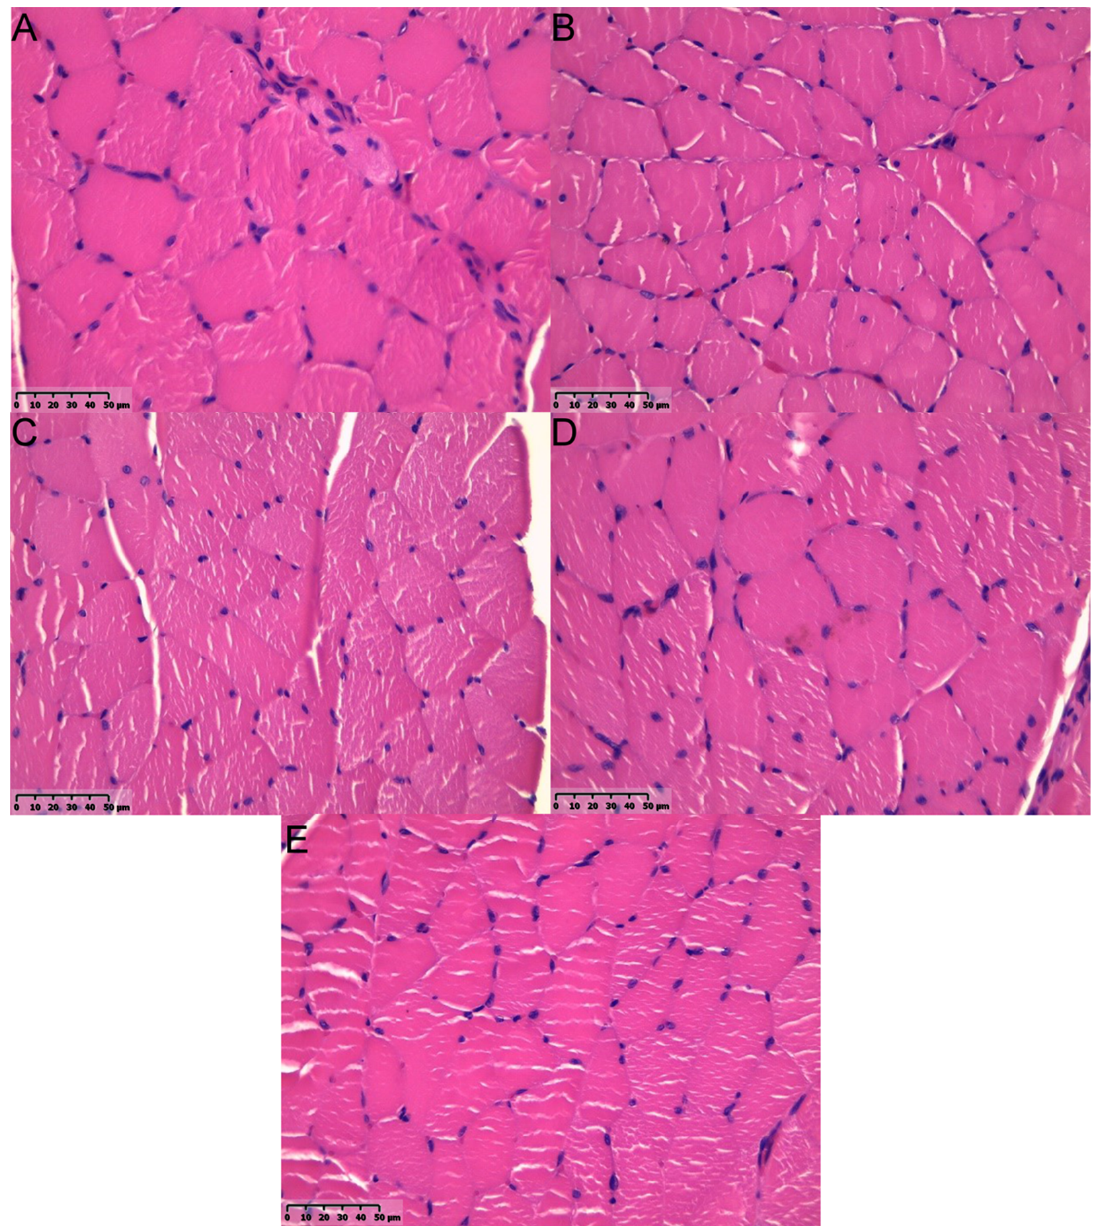
Figure 6. HE images of gastrocnemius muscle sections from the operated limb ( A – D ) and from random unoperated limb ( E ). ( A ) In the nerve gap group, the muscle fiber size is decreased; a higher number of nuclei was observed along with the increased prevalence of connective tissue between muscle fibers and inclusion bodies. ( B ) Autograft group—slightly increased number of inclusion bodies and increased number of nuclei and inclusion bodies. ( C ) P(LLA-CL)-COL-PANI conduit group—comparing to ( E ) slightly higher number of nuclei and connective tissue fibers were noted. ( D ) P(LLA-CL)-COL-PANI conduit with ASCs group—a higher number of inclusion bodies was noted. ( E ) Histologic image of a correct, unaffected muscle. Scale bar 50 µm